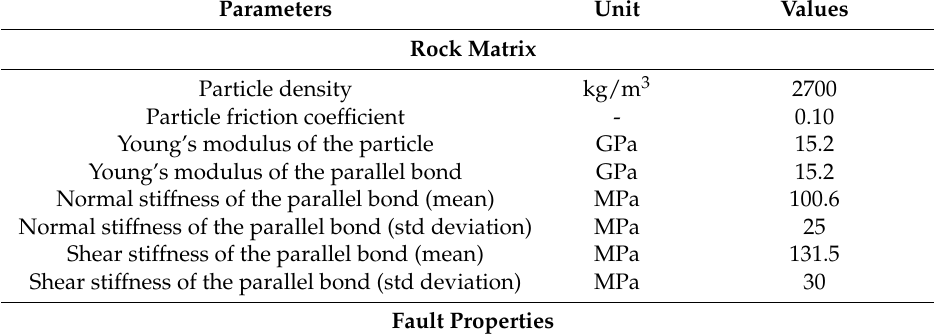
Normal stiffness of the parallel bond (std deviation) Shear stiffness of the parallel bond (mean) Shear stiffness of the parallel bond (std deviation)